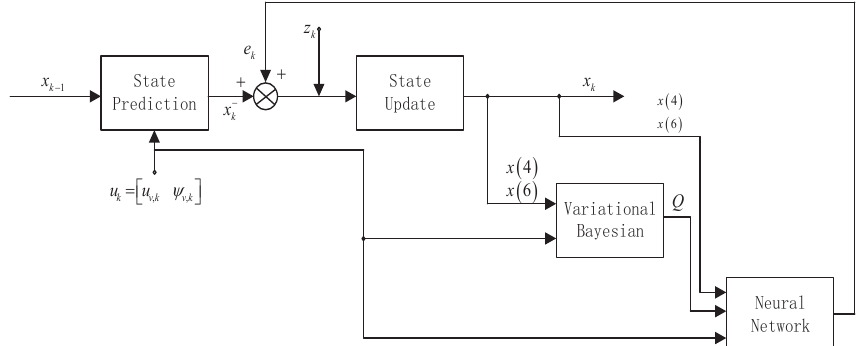
Figure 4. Structure of proposed adaptive target tracking algorithm based on EKF.